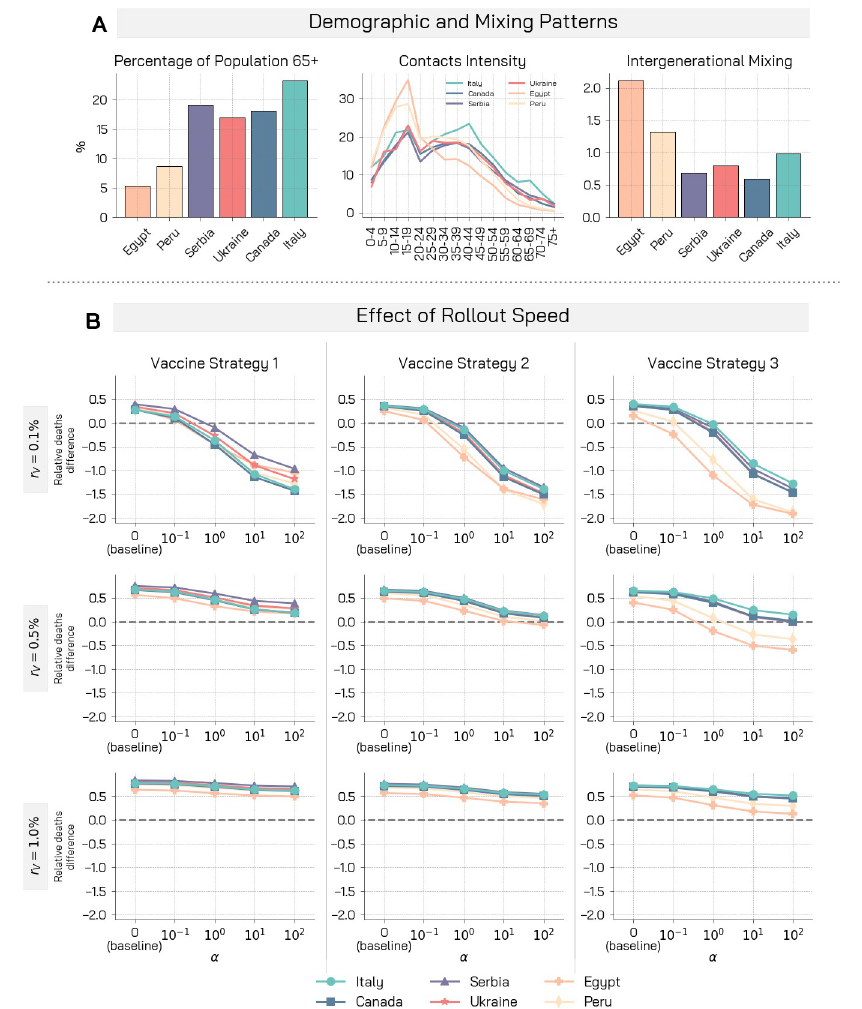
Fig 1. Demographic, mixing patterns, and relative deaths difference for different rollout speeds and prioritization strategies. A) Demographic characteristics and mixing patterns of the six countries considered are shown: percentage of the population aged over 65, contacts intensity for different age groups, and a measure of inter-generational mixing. B) Relative deaths difference is computed as the fraction of deaths that are avoided with a vaccine with respect to a baseline simulation without vaccine. We display results of the simulations for three vaccine rollout speed and prioritization strategies. Other parameters used are γ = 0.5, R 0 = 1.15, r = 1.3, VE VE = 90%, 0.5% of initially infected, 10% of initially immune individuals, and simulations length is set to 1 year.